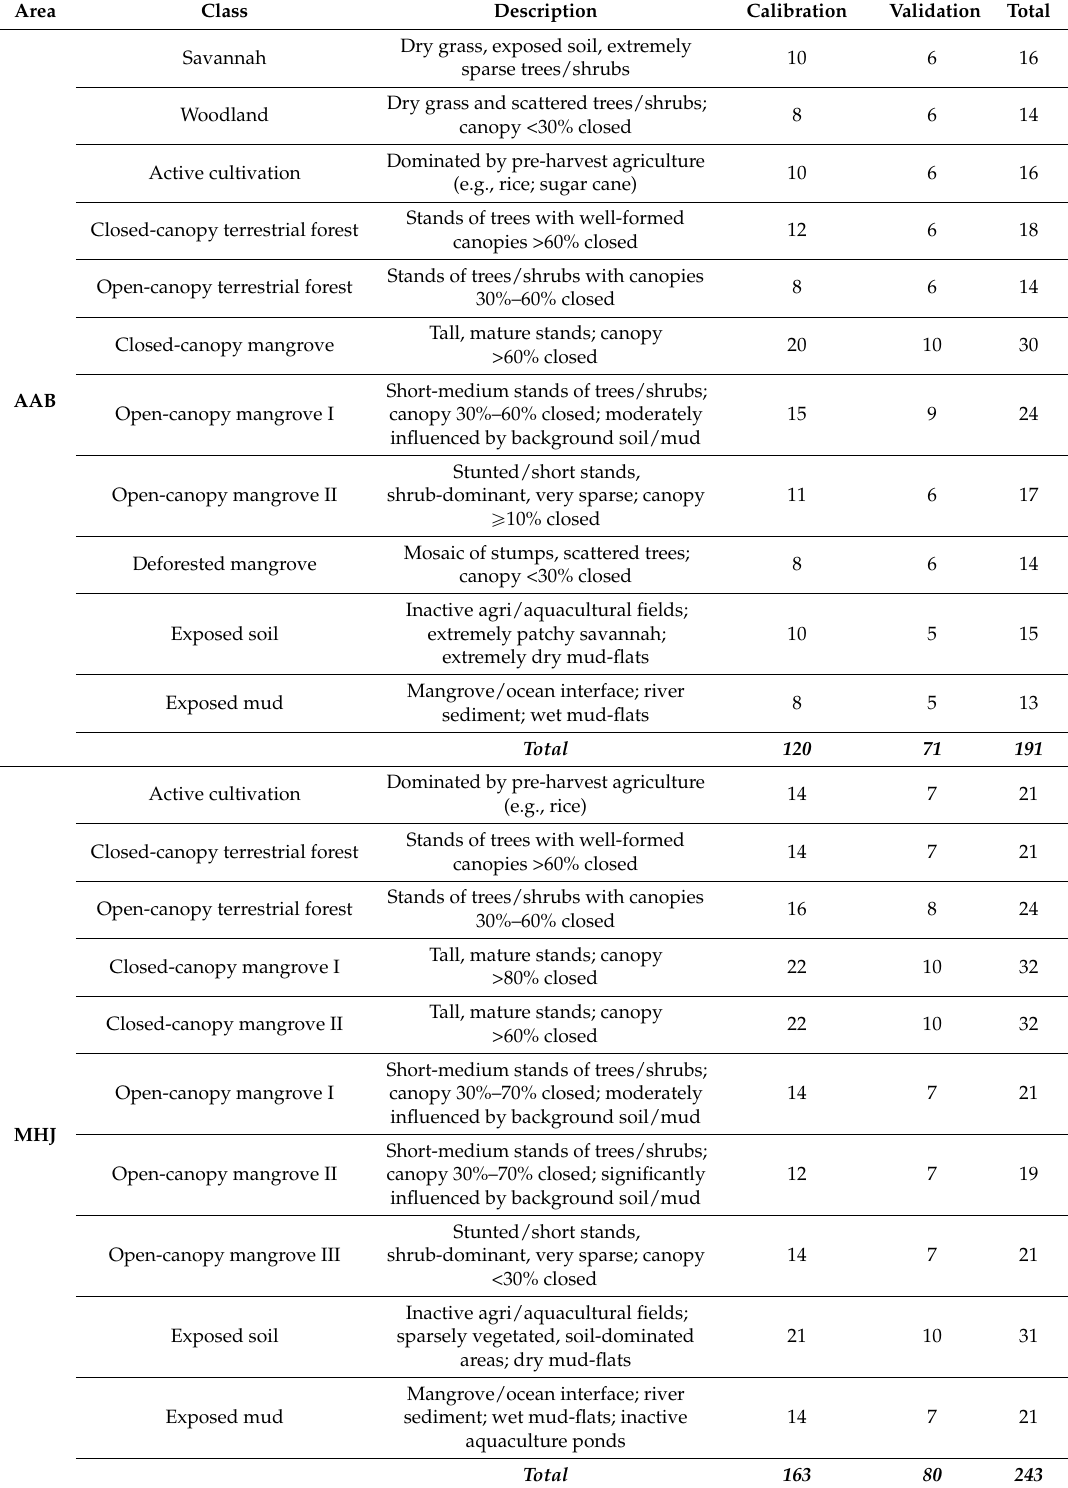
Table 2. Mapped classes, descriptions and 3 ˆ 3 pixel calibration and validation reference areas for each of the four AOIs. Mapped classes for TMD and BdA build on previously published studies for AAB ([25]) and MHJ